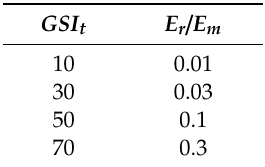
Table 2. Parameters for the parametric study.